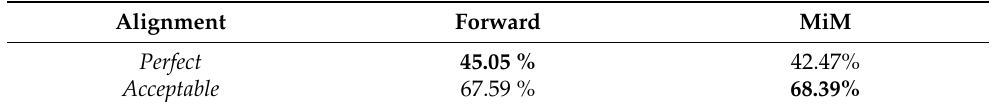
Table 2. Performance of the alignment method and its variants on the Moccia Code. The results are given in terms of accuracy. The best results are in boldface.